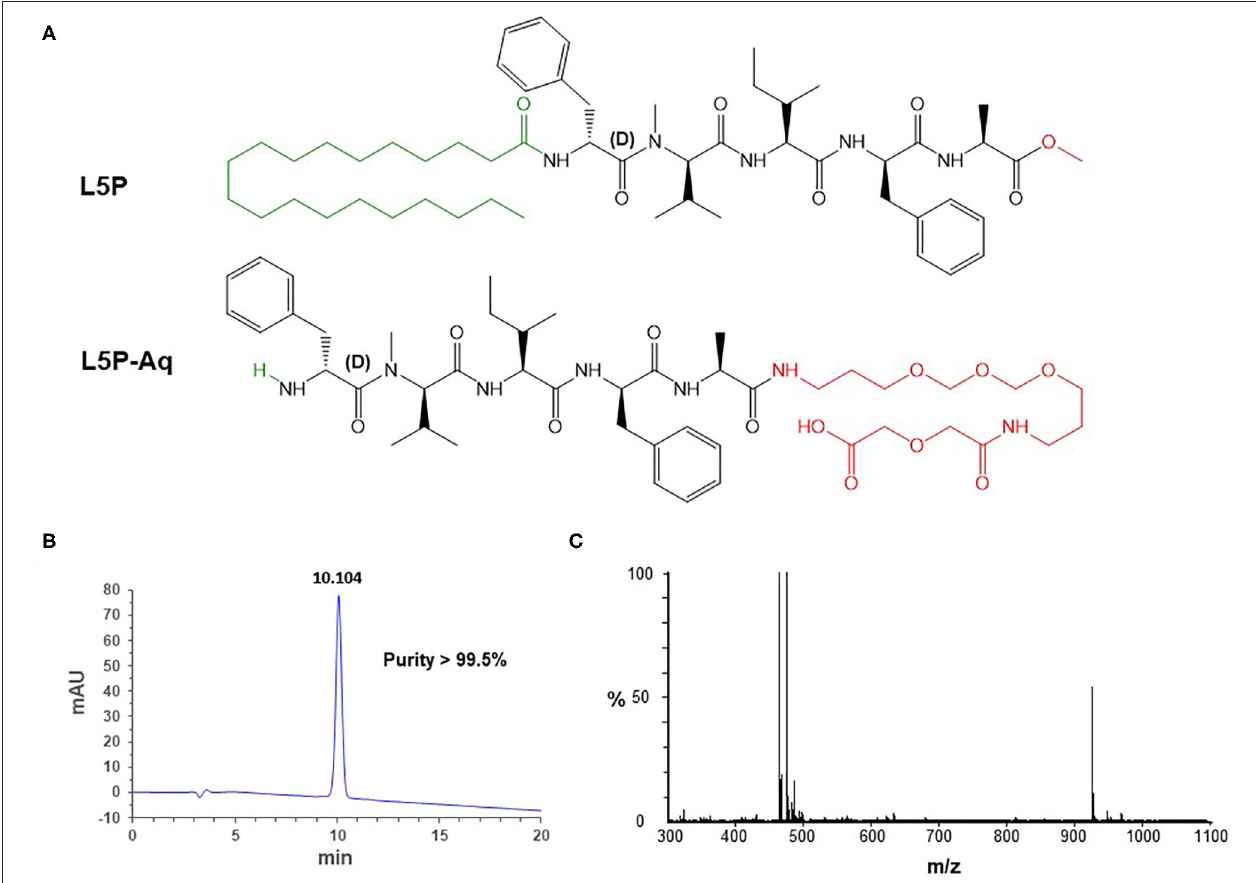
FIGURE 1 | Structural formulas of L5P and L5P-Aq (A) . The amino-acid residues belong to the L-series, unless otherwise specified. The N-ter and the C-ter moieties are indicated in green and red, respectively. Physico-chemical characterization of the purified synthetic L5P-Aq by RP-HPLC (B) and MS (C) . (B) Detection is performed by UV at 230nm (milli-absorption units). Purity is indicated in % area-under-the-curve. Retention time is indicated above the peak in min. (C) Mass/charge values in daltons: m/z 464.773 [M + 2H] 2 + (calcd 464.774), m/z 475.754 [M + H + Na] 2 + (calcd 475.765), m/z 928.555 [M + H] + (calcd 928.540), m/z 950.514 [M + Na] + (calcd 950.522). See Supplementary Figure 1 for NMR